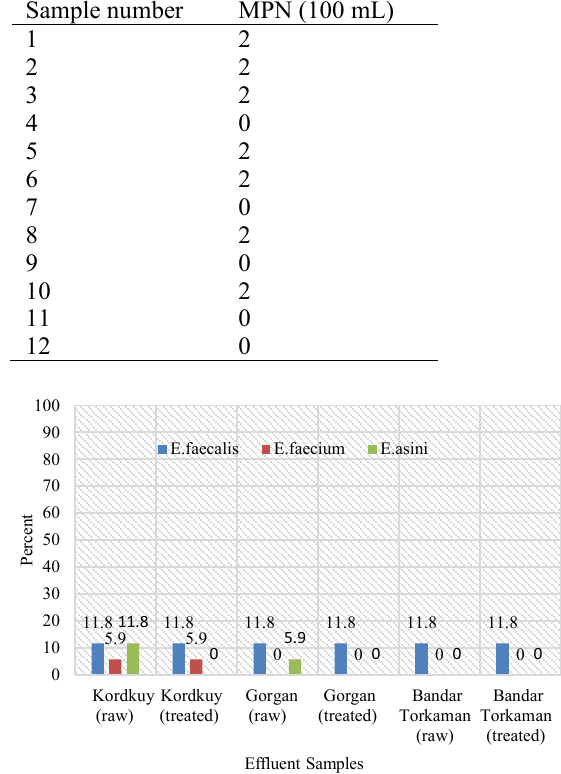
Table 1. Frequency of E. faecalis species isolated from wastewater samples by the MPN method